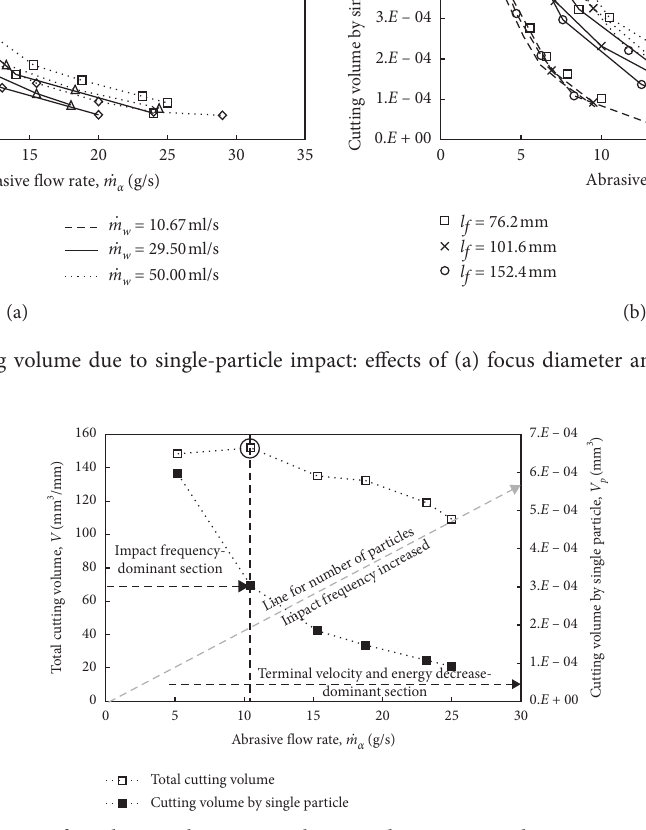
� 1 . 02 mm, l � 76 . 2 mm, and _ m f f